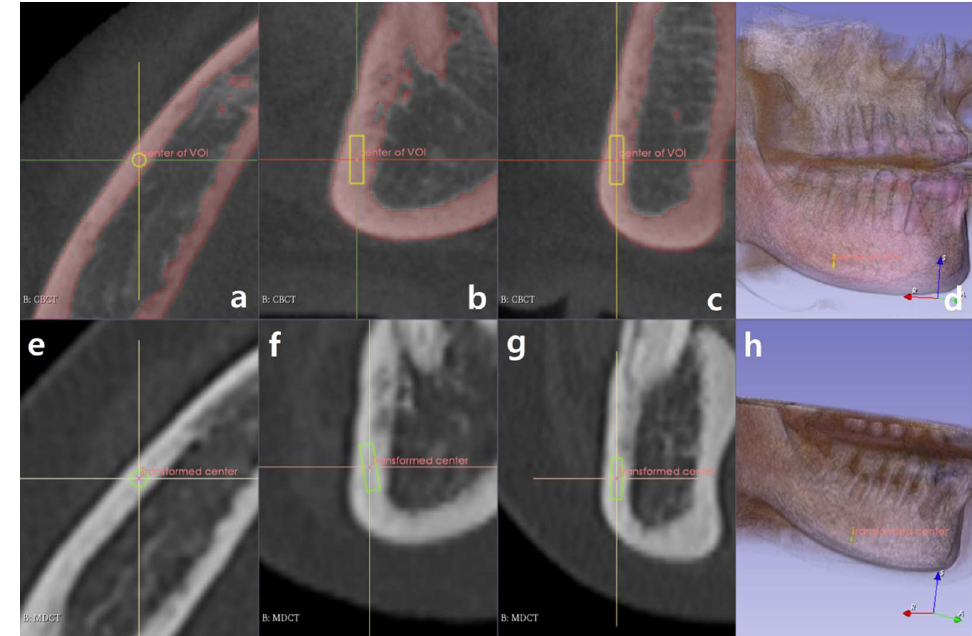
Figure 3. MPR views of DE CBCT and MDCT. Yellow perimeters and green perimeters indicate the selected region-of-interest (ROI) and transformed ROI, respectively: ( a ) axial view, ( b ) sagittal view, ( c ) coronal view, ( d ) 3D volume rendering of the DE CBCT image, ( e ) axial view, ( f ) sagittal view, ( g ) coronal view, and ( h ) 3D volume rendering of the MDCT image.